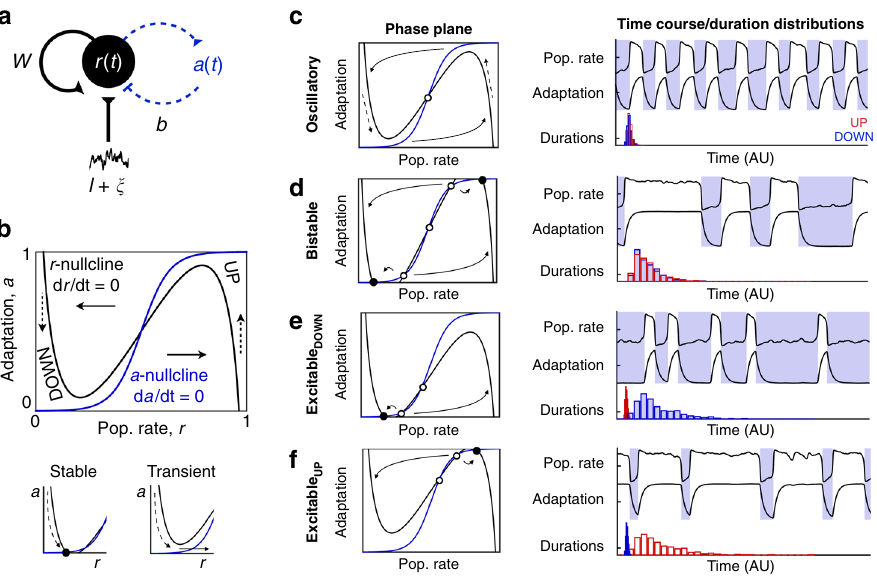
Fig. 2 UP/DOWN dynamics in an adapting recurrent neural population. a Wilson – Cowan-like model for a neural population with slow adaptive process. b r - a Phase plane. Model dynamics are seen as trajectories in the phase plane that follow Equations (1 – 2). Dashed arrows indicate slow vertical trajectories at timescale of τ a , solid arrows indicate fast horizontal trajectories at timescale of τ r . Nullclines (the two curves along which dr / dt = 0, da / dt = 0) and their intersections graphically represent dynamics for a given set of parameter values (parameters as de fi ned in C shown). Left and right branches of the r - nullcline correspond to DOWN and UP states, respectively. Stable UP/DOWN states are seen as stable fi xed points at nullcline intersections. Transient UP/DOWN states are seen as r -nullcline branch with no intersection. c – f Four UP/DOWN regimes available to the model, as distinguished by location of stable fi xed points (see also Supplementary Fig. 3). Representative phase plane (Left), simulated time course and UP/DOWN state duration distributions (right, time units arbitrary) for each regime. Stable fi xed points are represented by fi lled circles, unstable fi xed points by empty circles. Parameters: ( c – f ) b = 1, ( c , e , f ) w = 6 ( d ) w = 6.3, ( c ) I = 2.5 ( d ) I = 2.35 ( e ) I = 2.4 ( f ) I = 2.5. Default parameters speci fi ed in